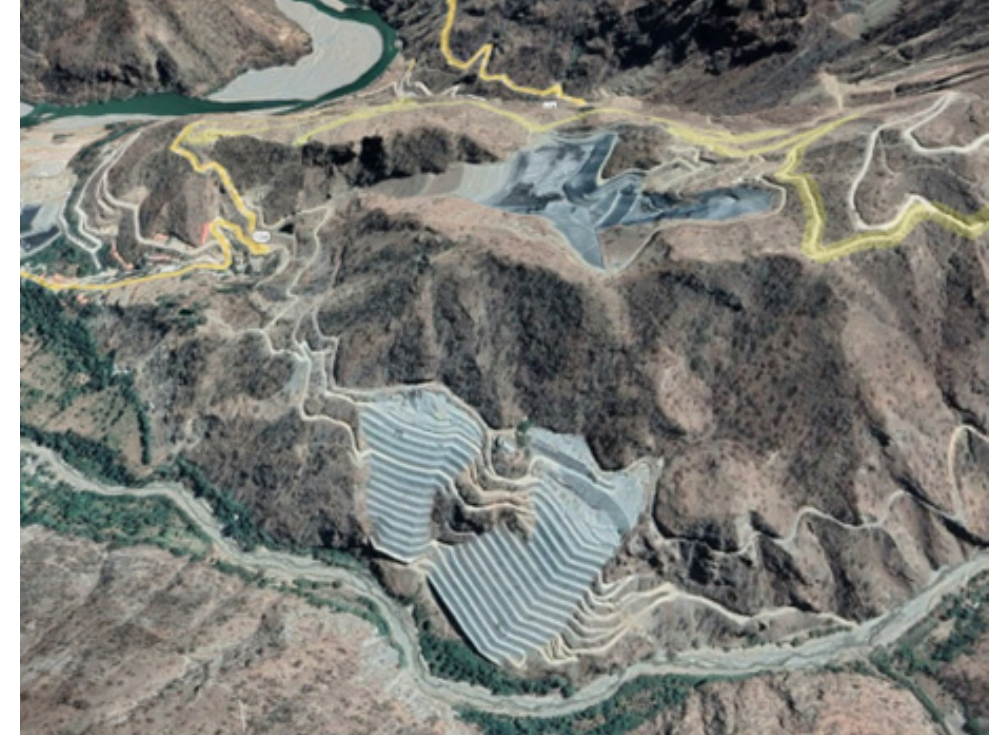
Figure 60. Poderosa Filtered Tailings Storage Facility Layout [36,37].